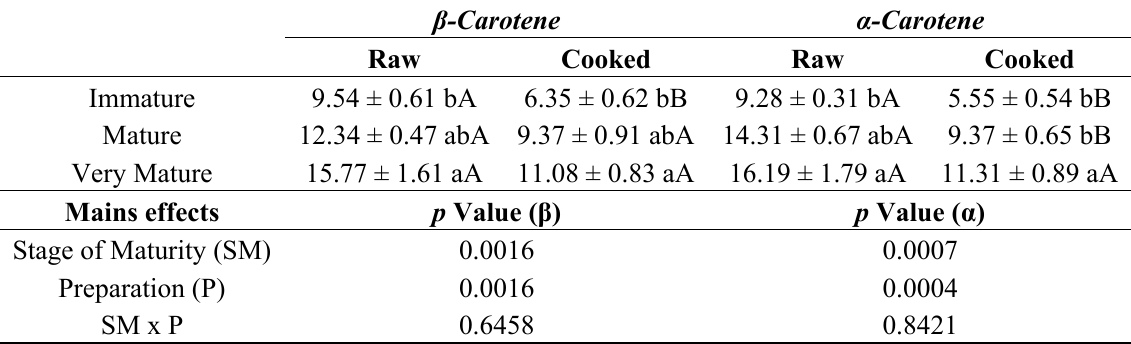
Table 1. Total content of β-carotene and α-carotene (mg.100 g −1 wet basis) in raw and cooked pulp from winter squash at three stages of maturity.